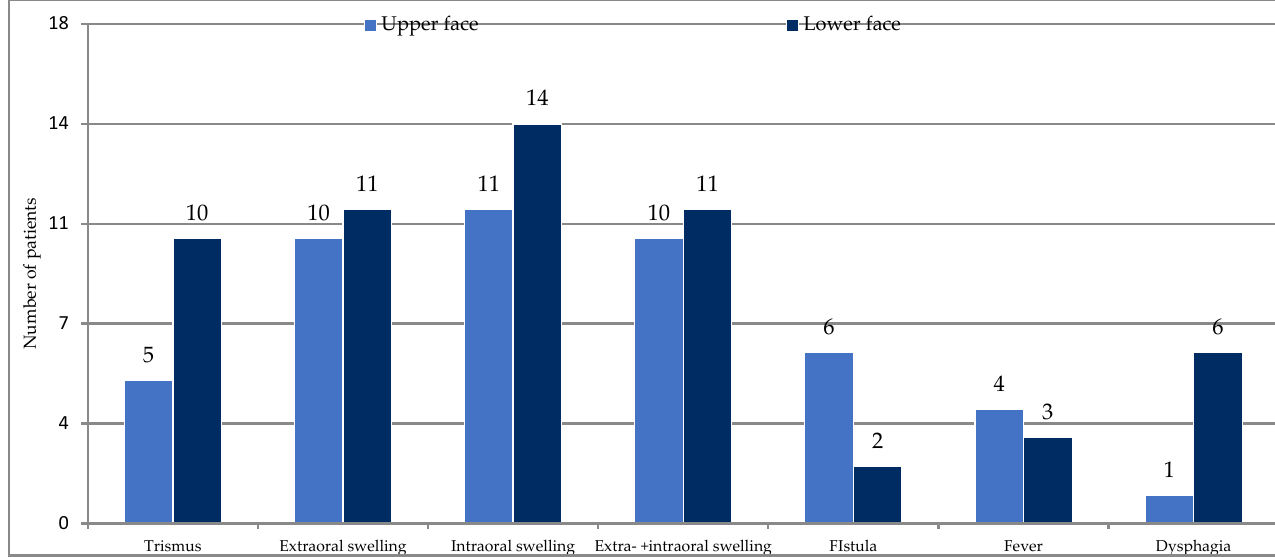
Figure 3. General symptoms in odontogenic infections of the upper and lower face.